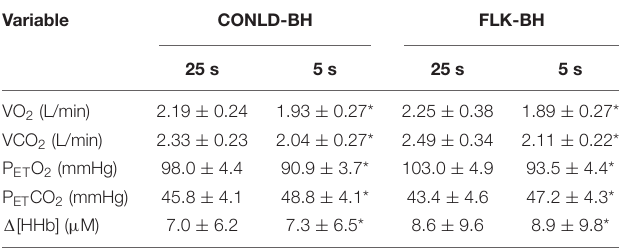
TABLE 4 | Mean outcome measures for both BH conditions (CONLD-BH and FLK-BH) for each 30 s apneic cycle (25 s regulated breathing, 5 s apnea) from 0 to 360